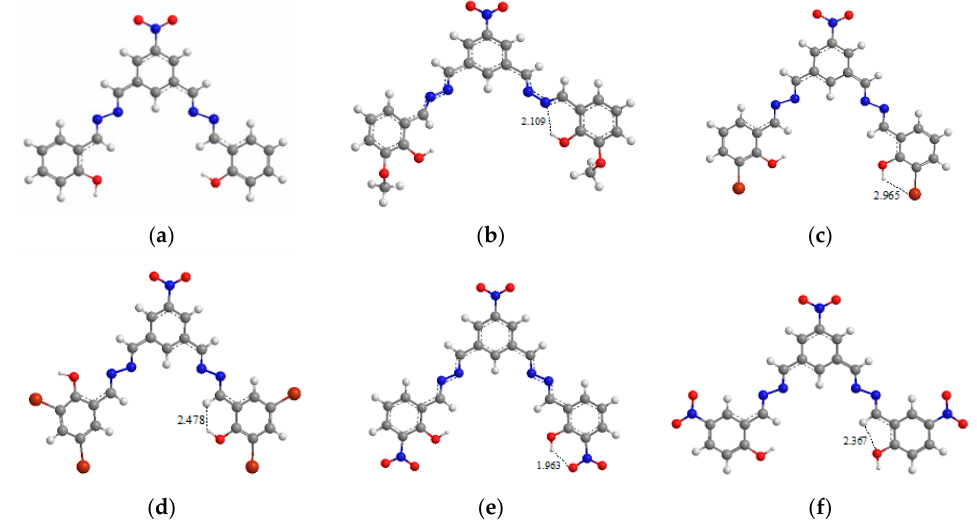
Figure 6. Optimized structures of six compounds. ( a ) Compound 1 ; ( b ) Compound 2 ; ( c ) Compound 3 ; ( d ) Compound 4 ; ( e ) Compound 5 ; ( f ) Compound 6 .